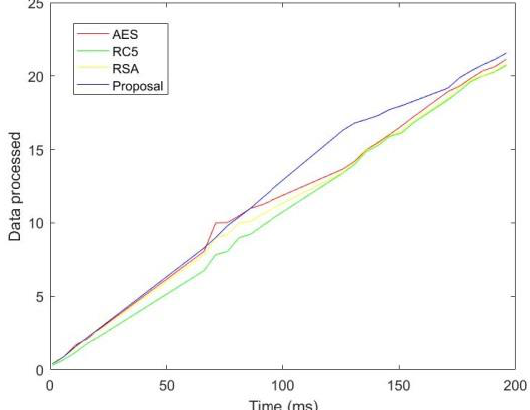
Figure 4. Performance of data processed (megabytes) comparison of the AES, RC5, RSA and proposed model.